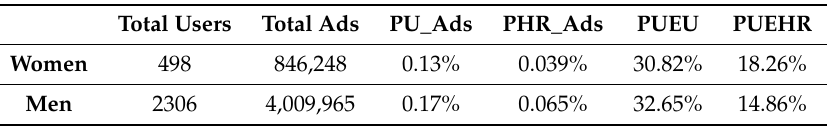
number of ads, (iii) the percentage of unsafe ads (PU_Ads), (iv) the percentage of highly risky ads (PHR_Ads), (v) the percentage of users exposed to unsafe ads (PUEU), and (vi) the percentage of users exposed to highly risky ads